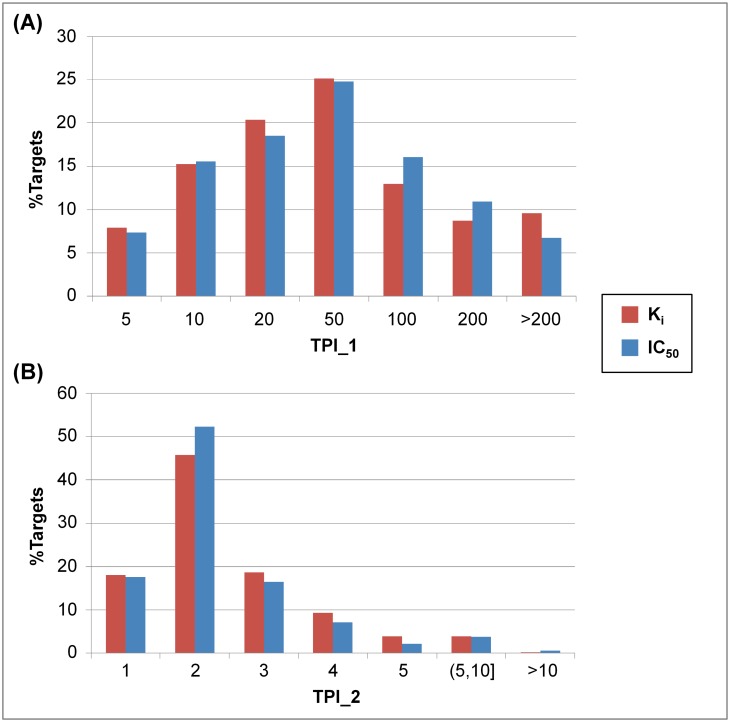
Distribution of target promiscuity indices.Shown is the distribution of (A) TPI_1 and (B) TPI_2 values for 354 targets from the Ki (red) and for 649 targets from the IC50 set (blue), respectively. For each of these targets, at least 10 active compounds were available.